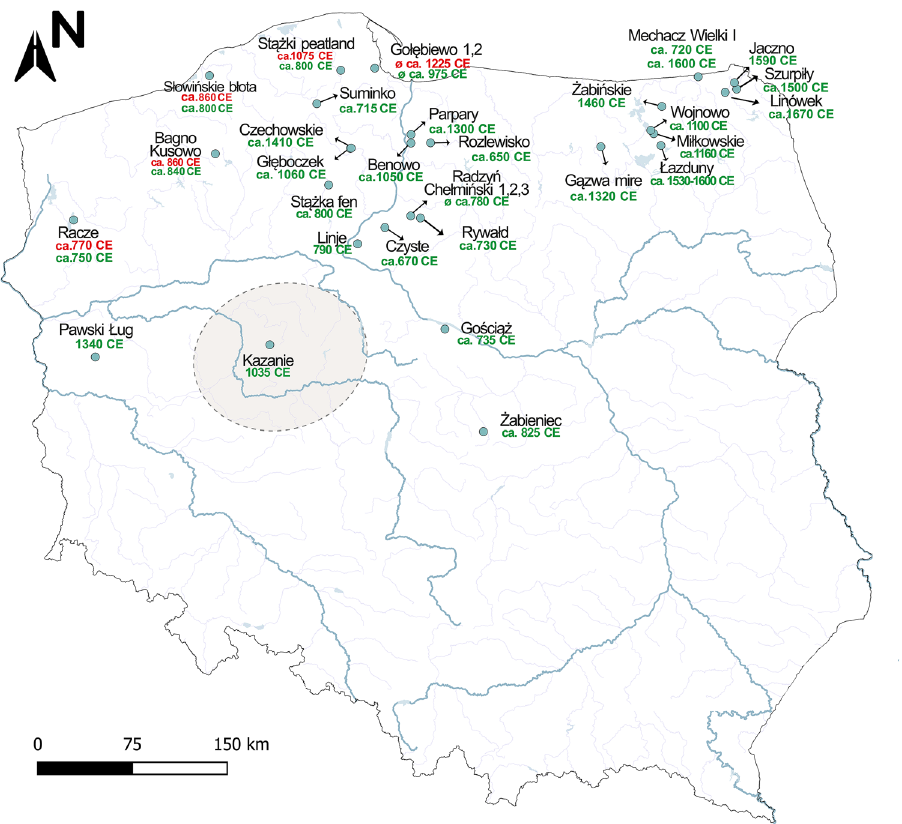
Figure 2. Geographical distribution of sites from the date at which Carpinus betulus (green) and Fagus sylvatica (red) peaked before decline commenced during the last 1500 years. The area enclosed by a dashed circles indicates the Greater Poland region. Map constructed by SC with QGIS 3.16.0 ’Hannover’ (https:// qgis. org/ en/ site/ index. html) and Corel Draw × 8 (https:// www. corel draw. com/